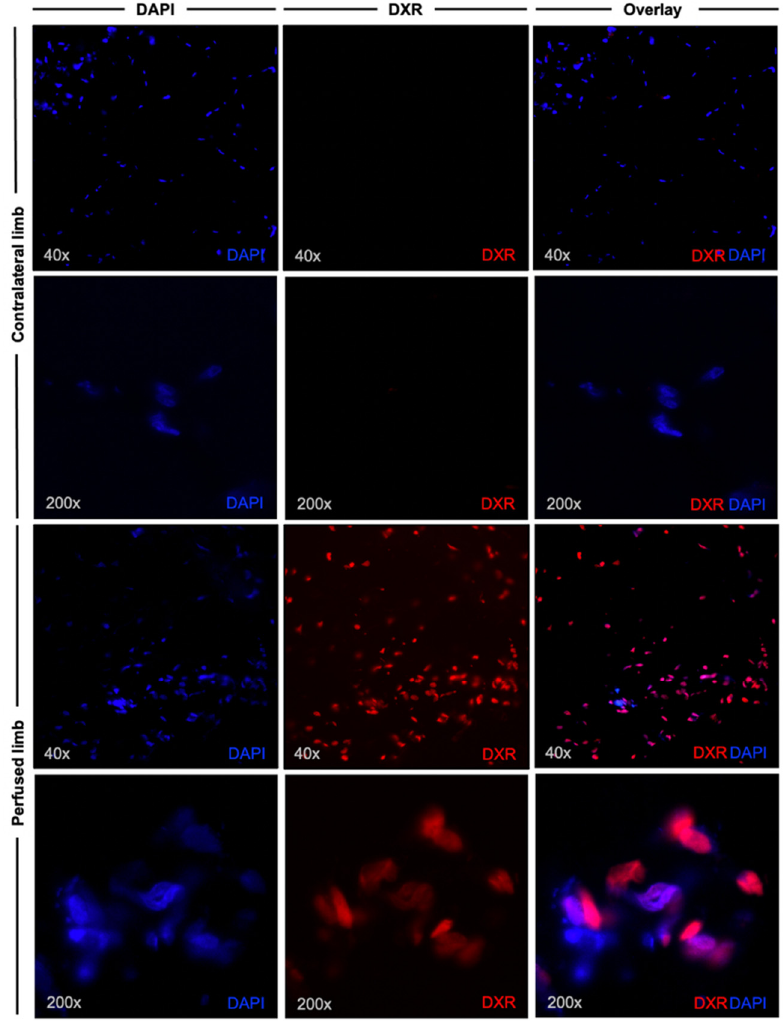
Figure 2. Fluorescence microscopy. In the first and second row, images of the sample derived from the contralateral limb are shown at 40× and 200× magnification, respectively. No intracellular doxorubicin (DXR) accumulation was observed, and nuclei were counterstained with DAPI. In the third and fourth row, fluorescence images of a sample from the perfused limb are displayed. Microscopic analysis displays intracellular doxorubicin accumulation.